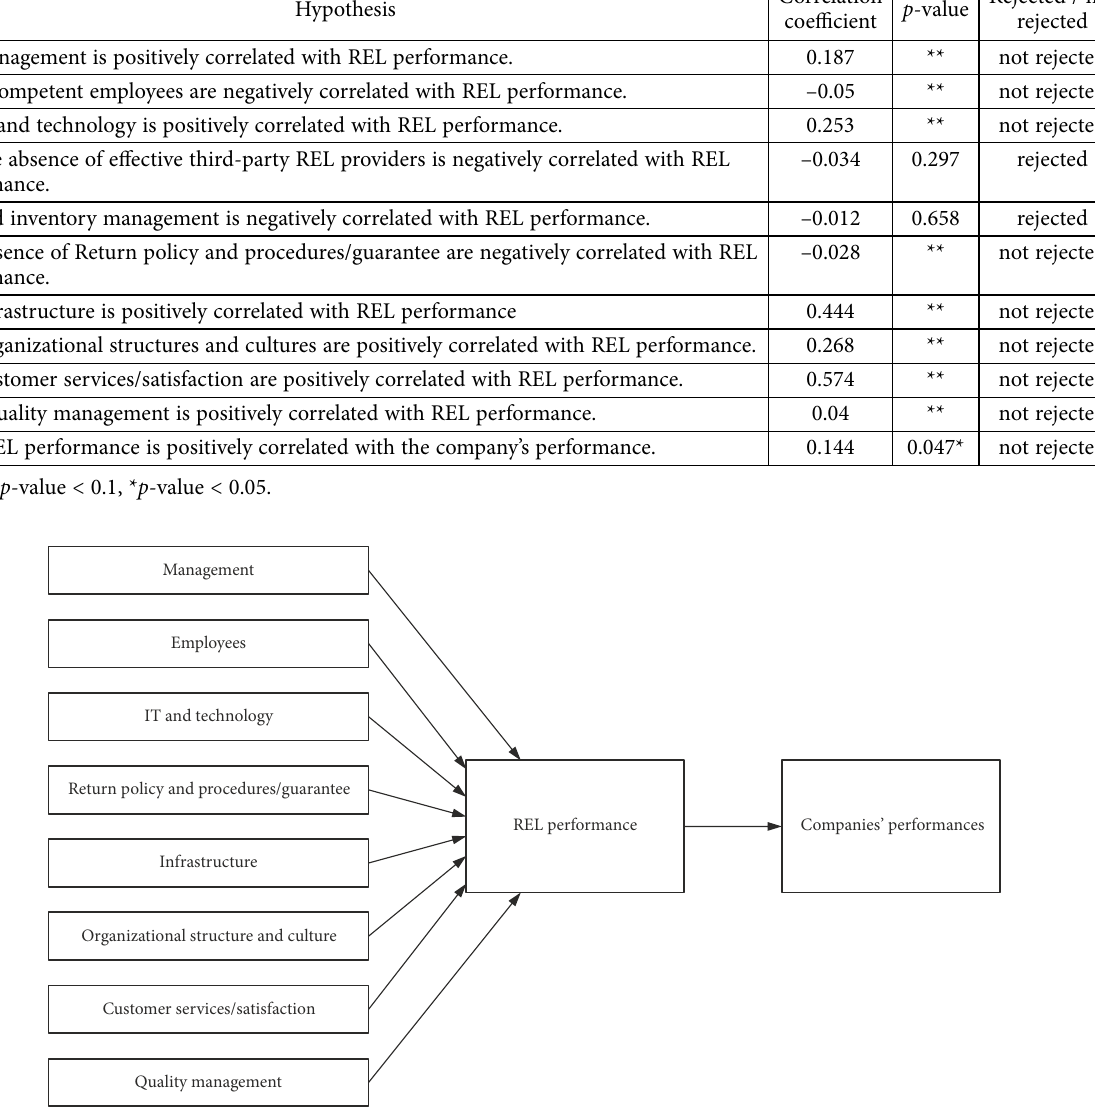
Correlation coefficient